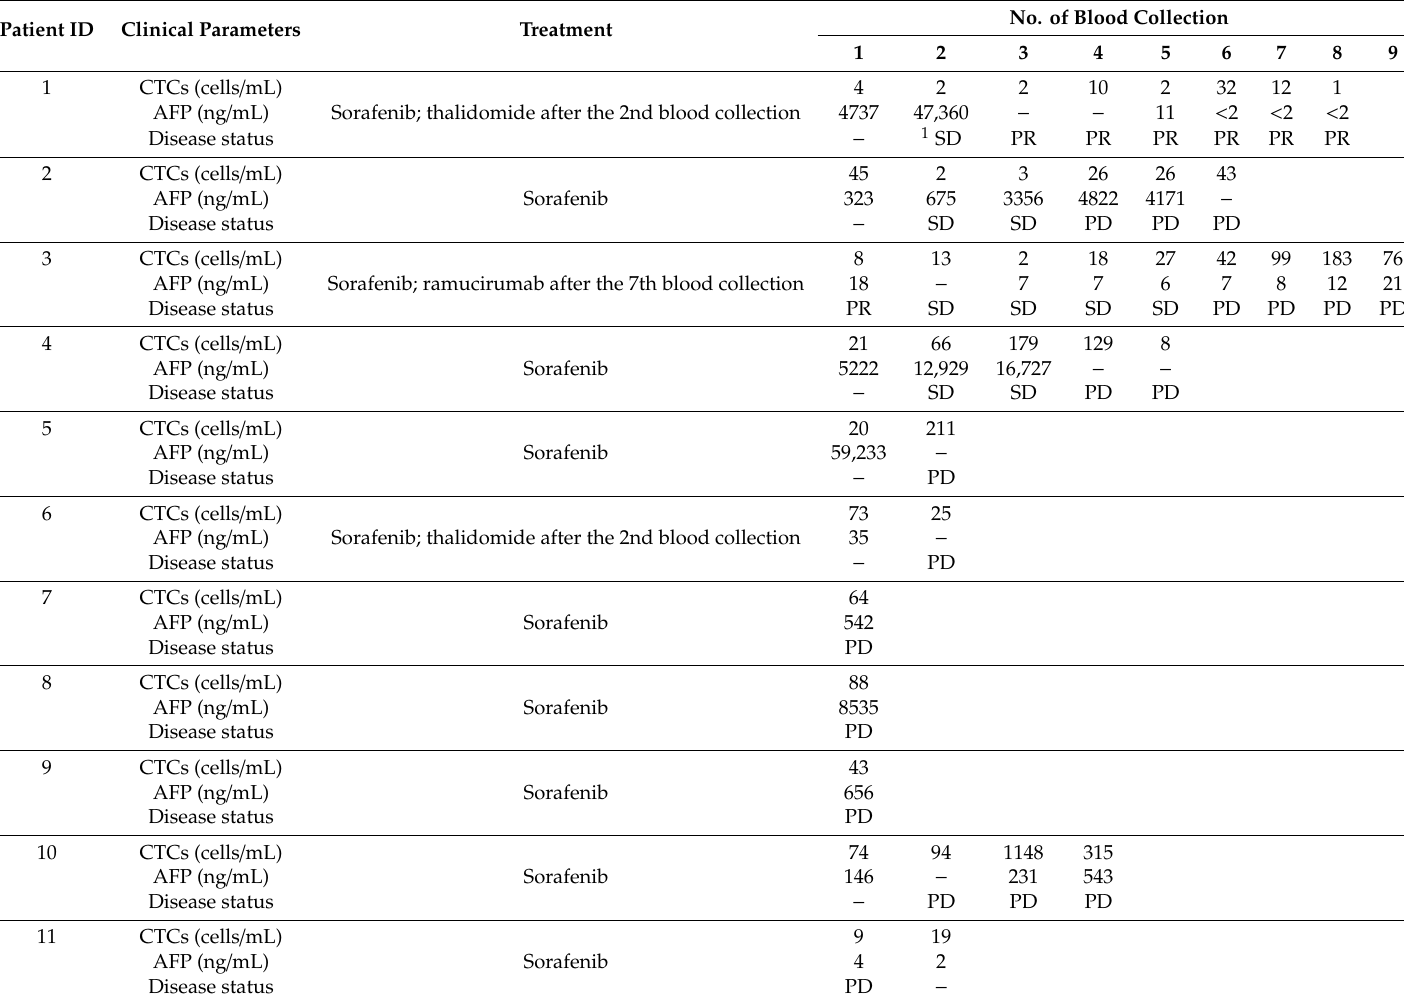
Table 2. The testing results for circulating tumor cells (CTCs) and alpha-fetoprotein (AFP) and the disease status of patients with hepatocellular carcinoma (HCC). Patient ID Clinical